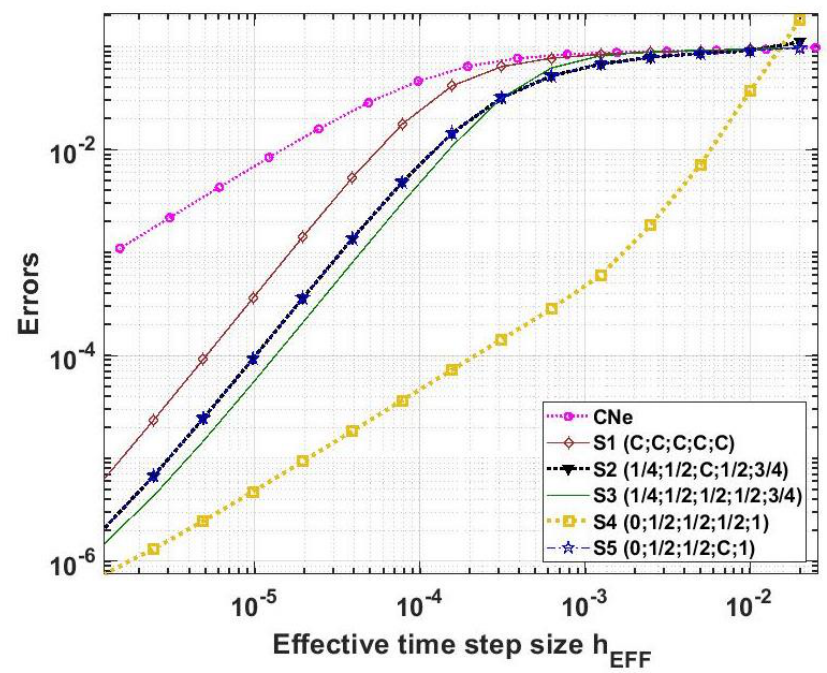
L h Figure 10. The L ∞ errors as a function of h EFF for the numerical solutions of Fisher’s equation for Figure 10. The for the numerical solutions of Fisher’s equation for  errors as a function of EFF α = 1 and β = 1  and 2  .